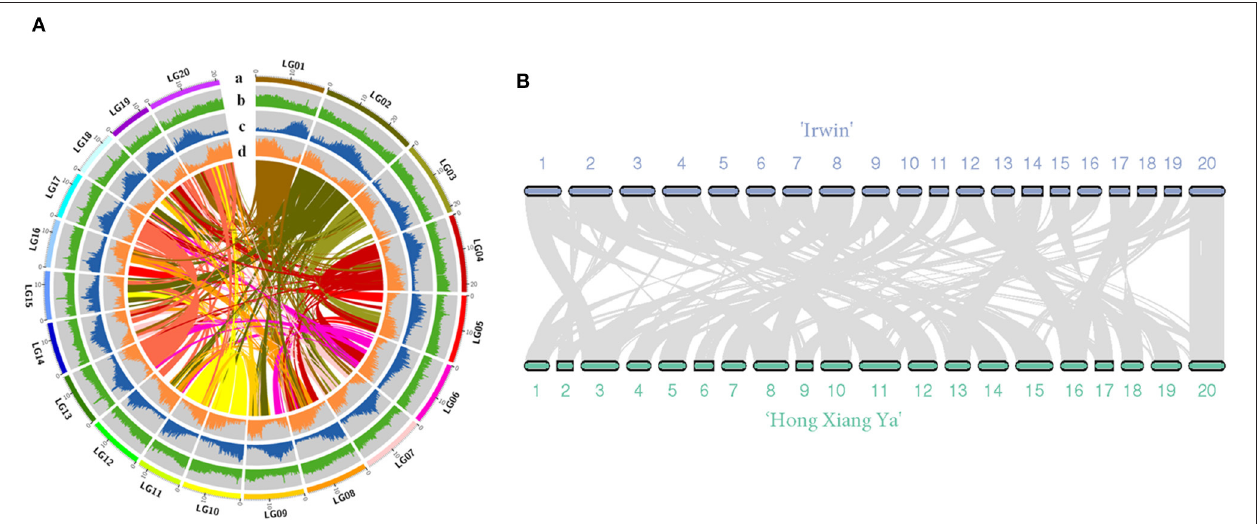
Frontiers in Plant Science |